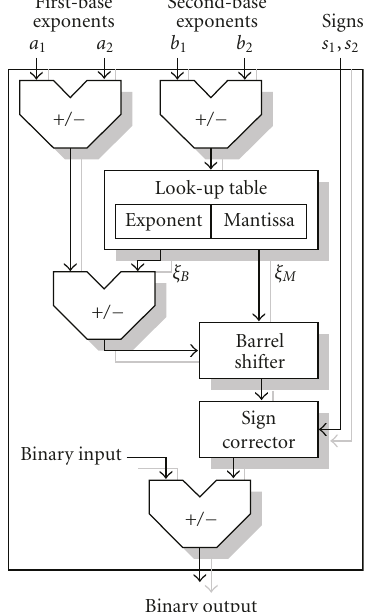
Figure 1: One-digit 2DLNS inner product computational unit from